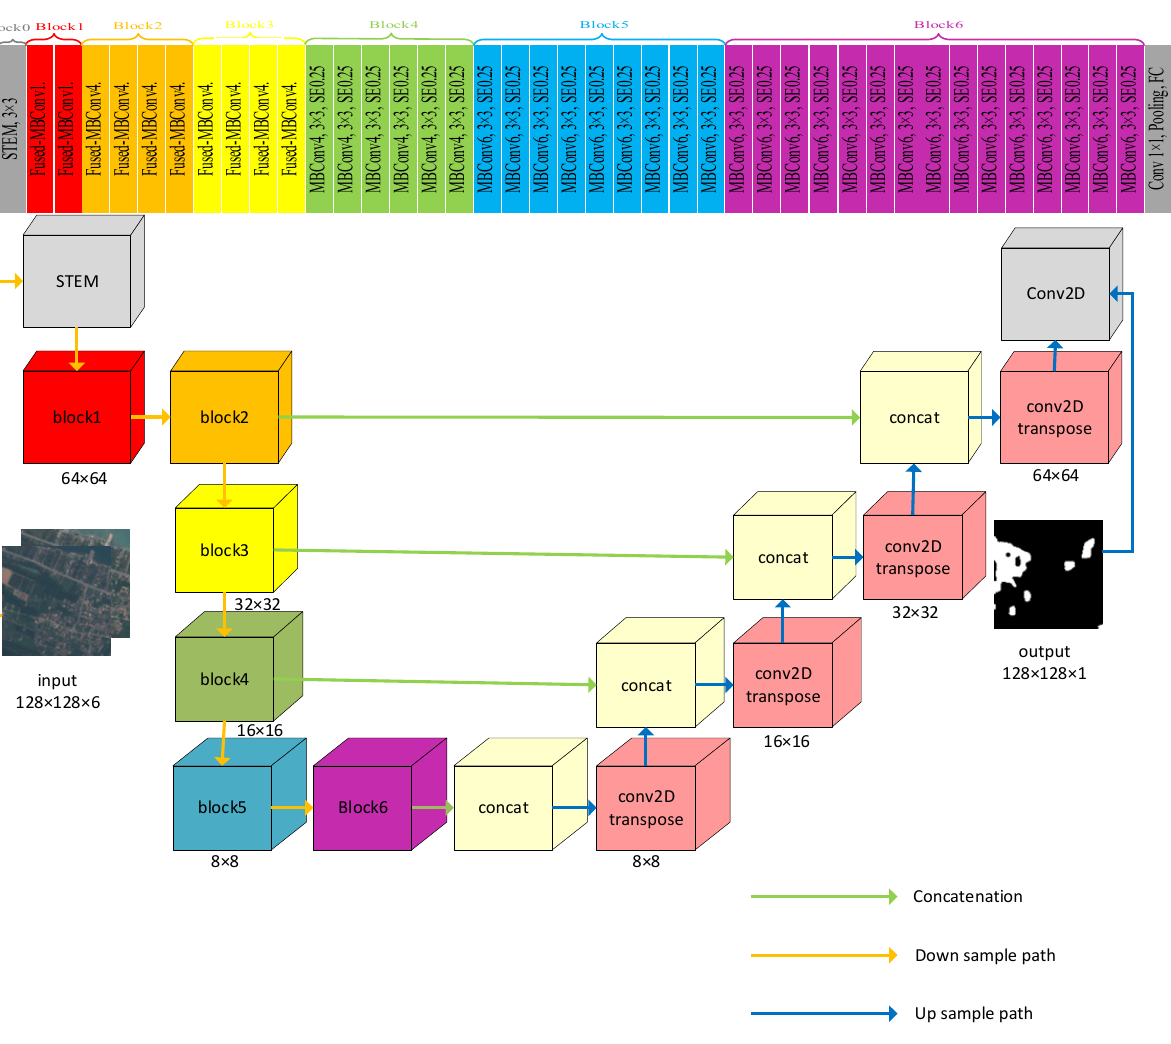
Figure 6. Top: the structure of EfficientNetV2 T, which contains seven blocks (represented with a different color); bottom: the structure of our proposed method using EfficientNetV2 T as an encoder and the convolutional layers of Unet as a decoder. The encoder is concatenated with the decoder at four different resolutions (Block2, Block3, Block4, and